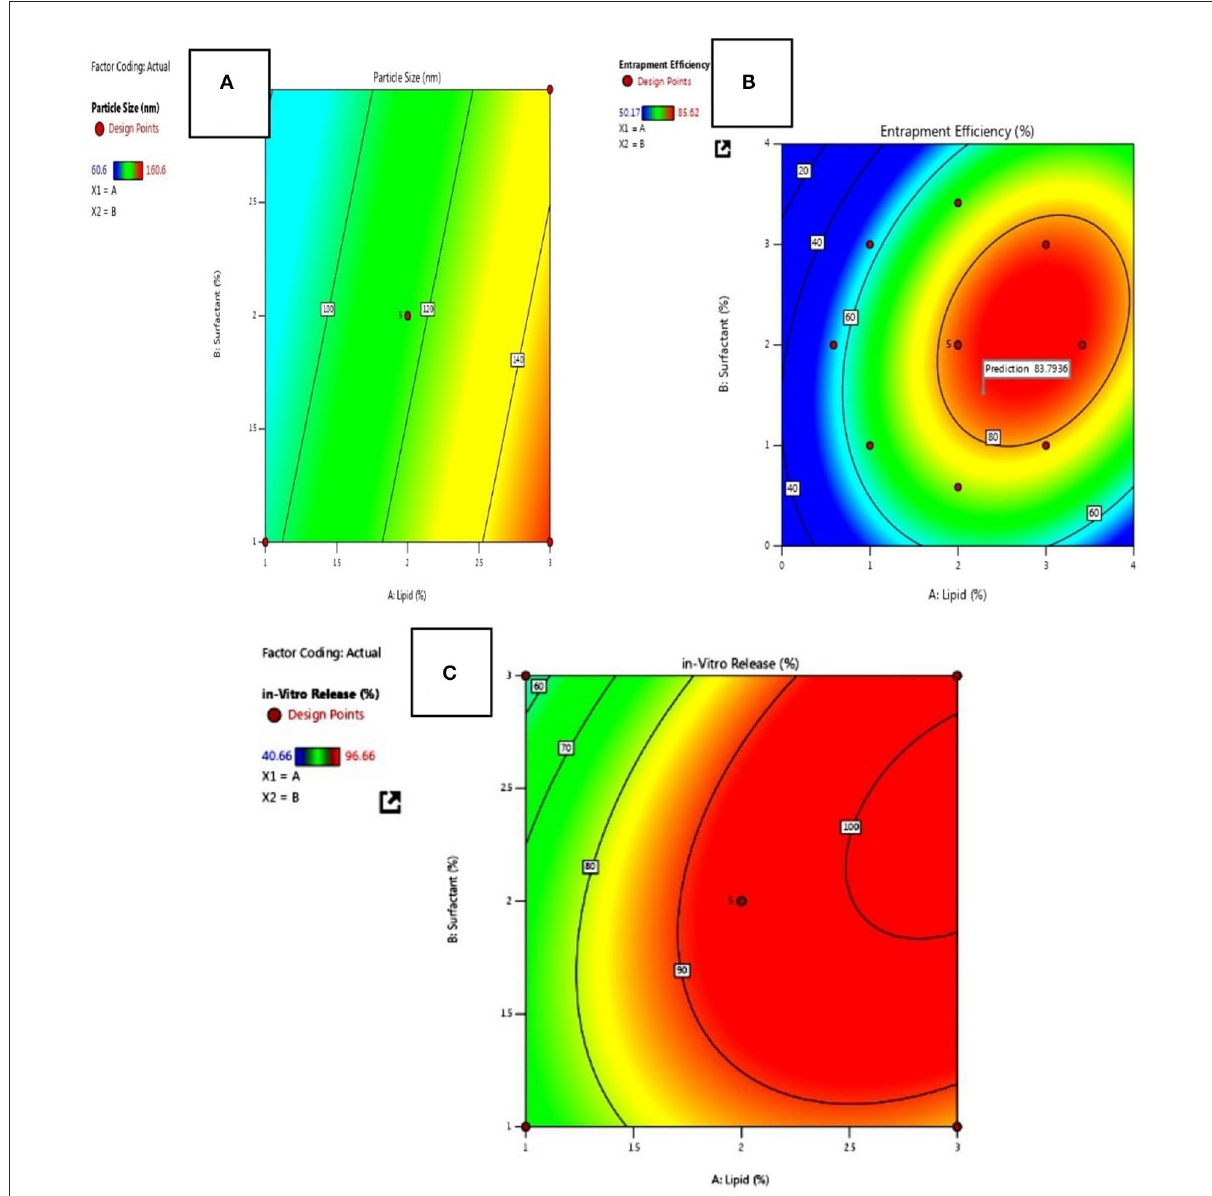
FIGURE2 2-D contour plots for (A) particle size, (B) % entrapment efficiency, and (C) in vitro drug release.